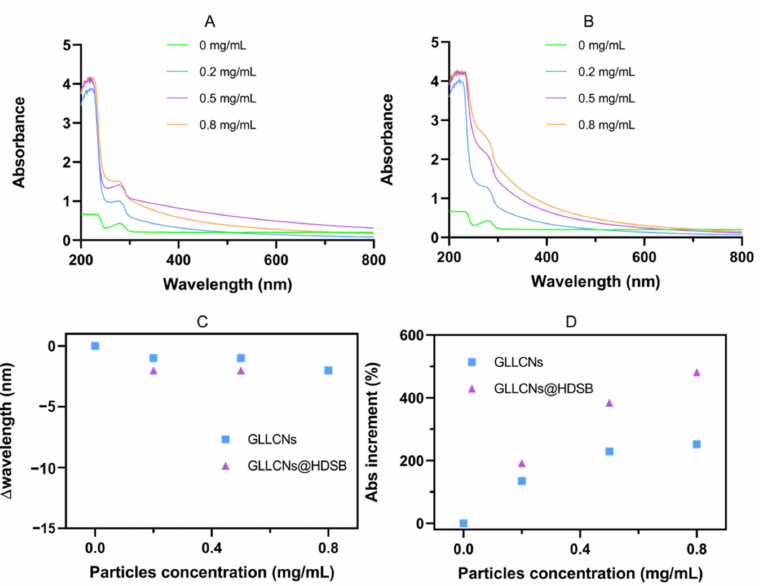
Figure 2. ( A , B ) UV-Vis spectra of BSA incubated with GLLCNs and GLLCNs@HDSB at different concentrations. ( C ) The ∆ wavelength of GLLCNs and GLLCNs@HDSB. ( D ) The Abs increment of GLLCNs and